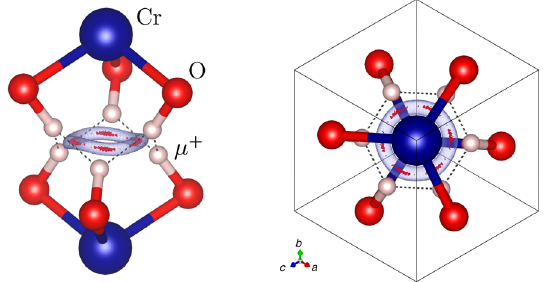
FIG. 8. Example configuration of electrostatically equivalent muon sites based solely on symmetry considerations and the constraint that muon stopping sites (white spheres) are located 1 Å away from an oxygen (red spheres). The close proximity of nearby sites suggests localized hopping. The electrostatic poten- tial isosurface of the undistorted crystal structure is shown in blue, with the red patches indicating local electrostatic minima corresponding to the position of the so-called Rodriguez sites